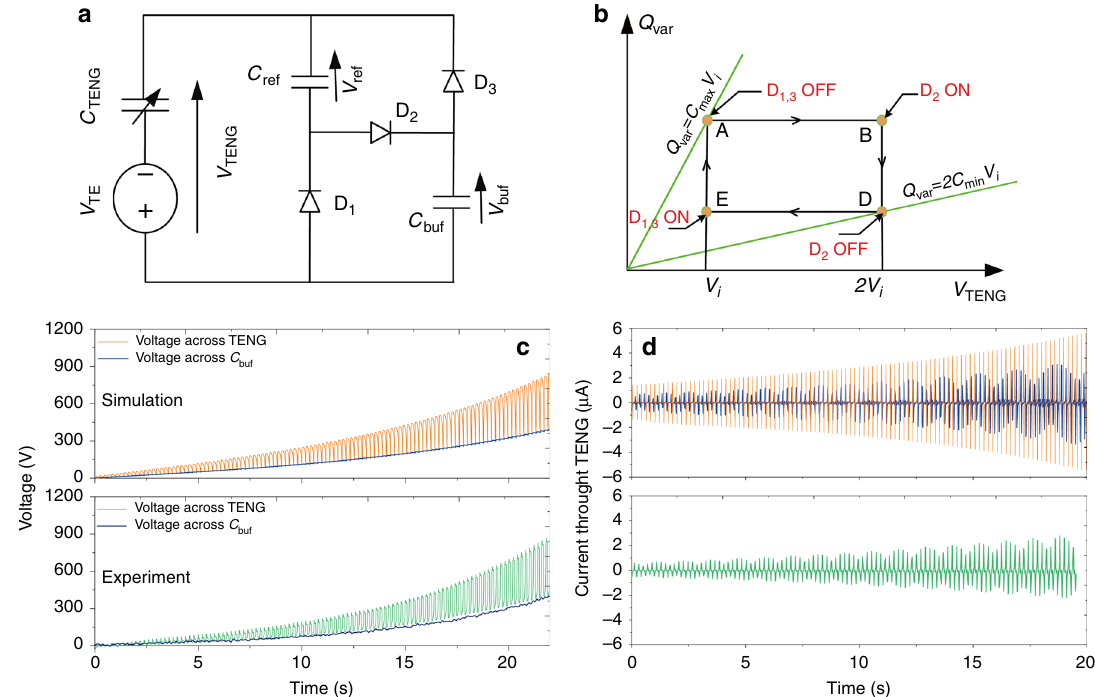
Fig. 2 Operation principles and electrical characterizations of the Bennet doubler. a Equivalent circuit of the TENG as well as the Bennet doubler. b Theoretical QV cycle of the TENG at i th cycle with Bennet doubler in the steady-state. c Simulated and measured voltages across the TENG and C buf . d Simulated and measured currents through the TENG. In the upper fi gure of ( d ), the orange curve indicates a sampling rate of 10 kHz while the blue curve indicates a low value of 50 Hz that was used in our pico-ampermeter. Source data are provided as a Source data fi Fig. 5 con fi rms that the exponential voltage increase with the original Bennet doubler occurs only if C max > 2 C min .